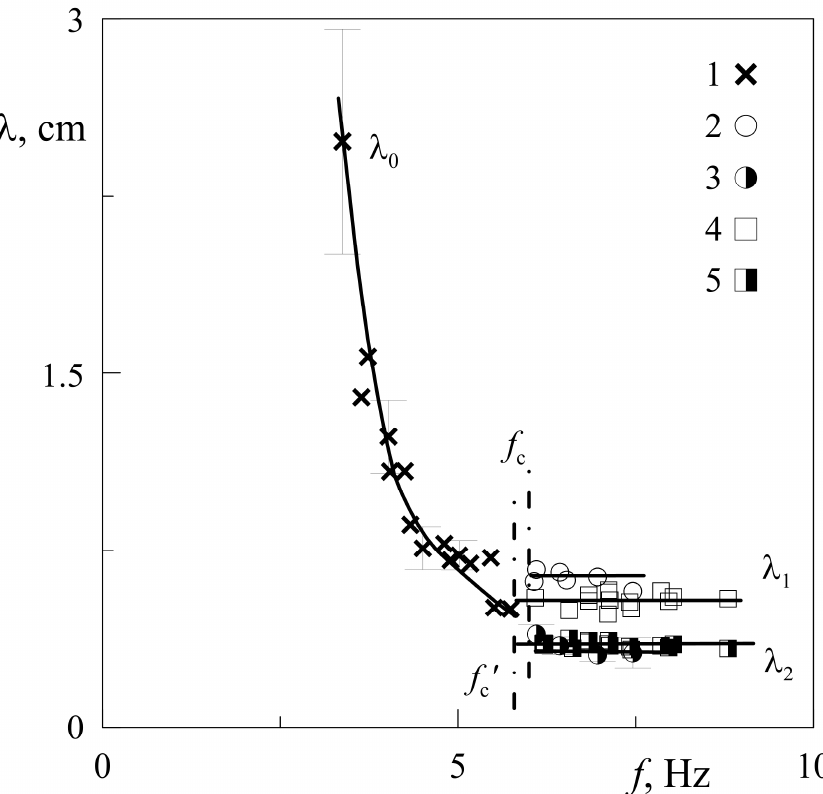
Figure 5. The wavelength of the structures (PIV particles) depending on the vibration frequency in the ethanol layer with a thickness h = 0.42 cm (points 1–3); thermochromic visualization in layer h = 0.32 cm (points 4 and